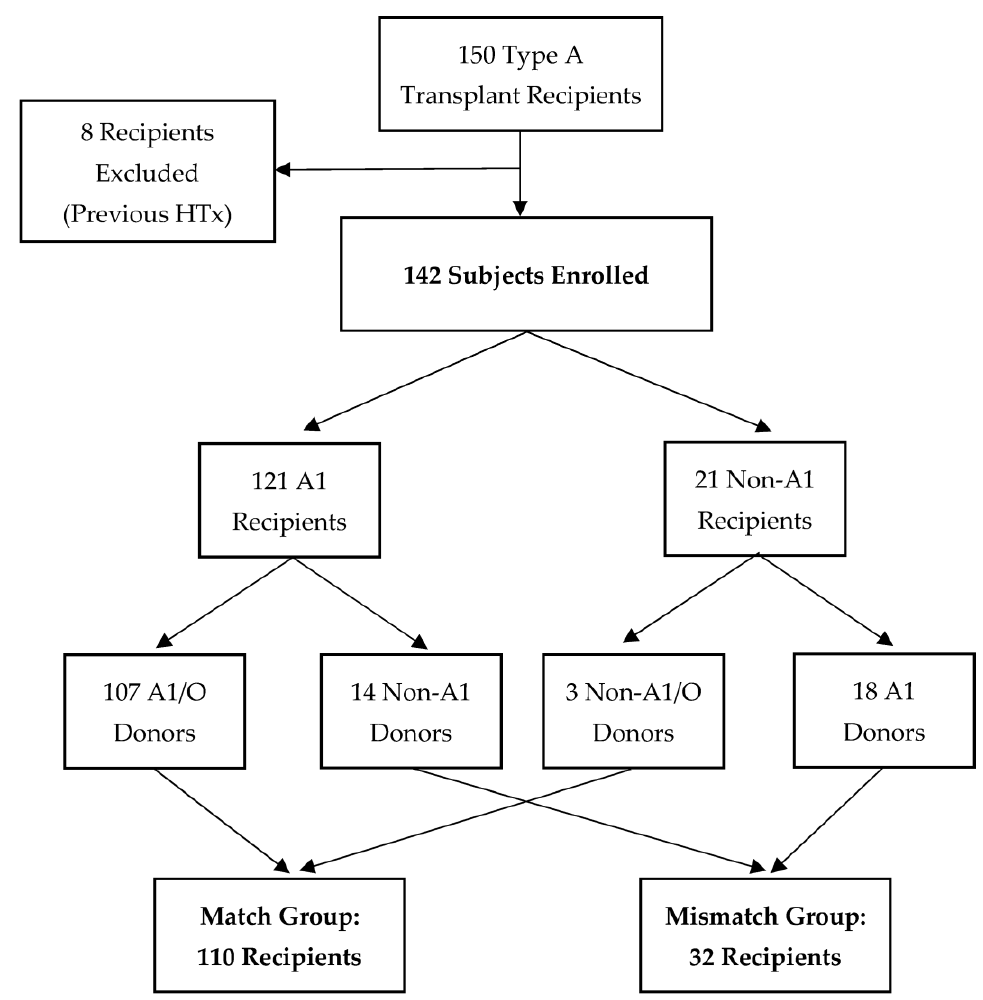
Figure 1. Allocation of Subjects into Match and Mismatch